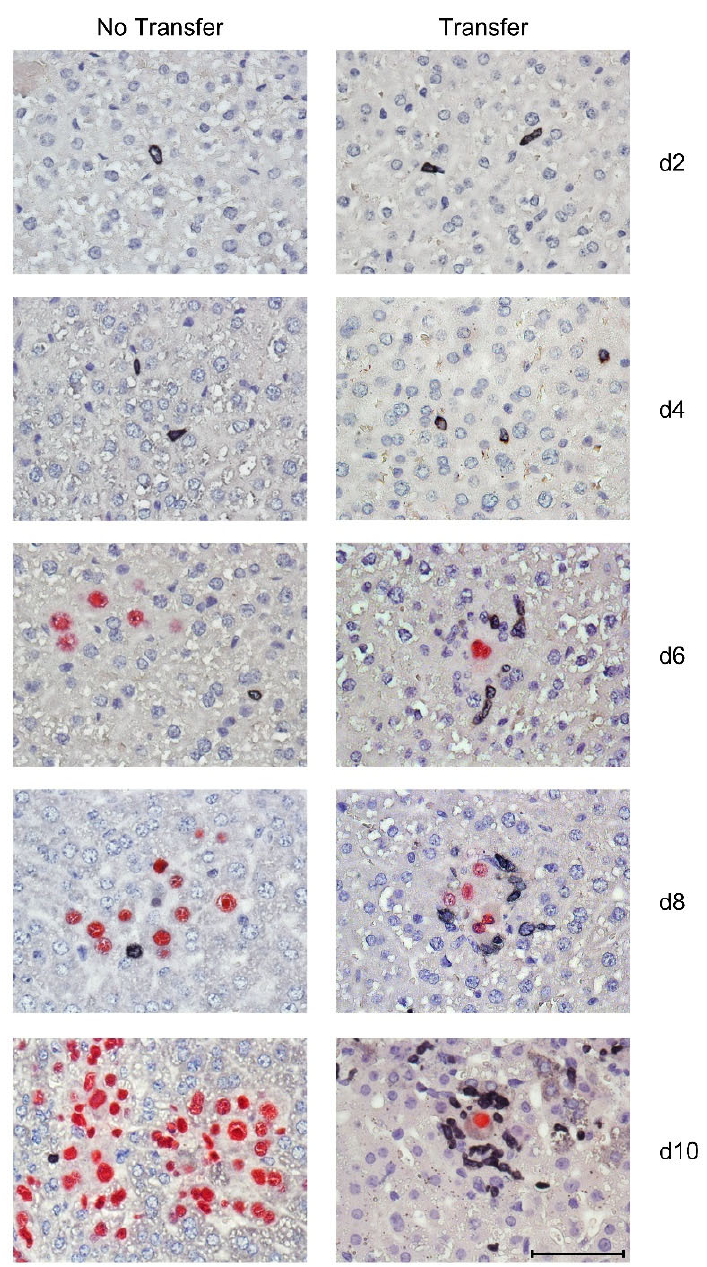
Figure 4. 2C ‐ IHC images showing the time course of NIF formation after CD8 ‐ AT. Infected liver cells, which are primarily hepatocytes, are identified by red staining of the intranuclear viral protein IE1. Tissue ‐ infiltrating, NIF ‐ forming CD8 T cells are identified by black staining of the CD8a molecule. Light hematoxylin counterstaining reveals the context of liver tissue. In the absence of CD8 ‐ AT, NIF are not formed, and the virus spreads unhindered. The bar marker represents 50 μ m and applies to all images.